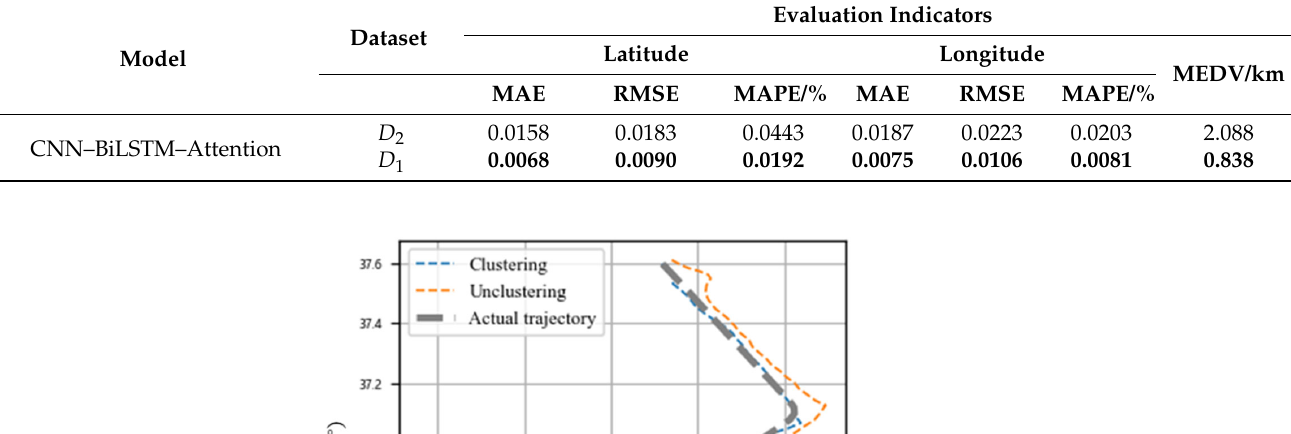
Table 4. Comparison of clustering and unclustering data in evaluation indicators.